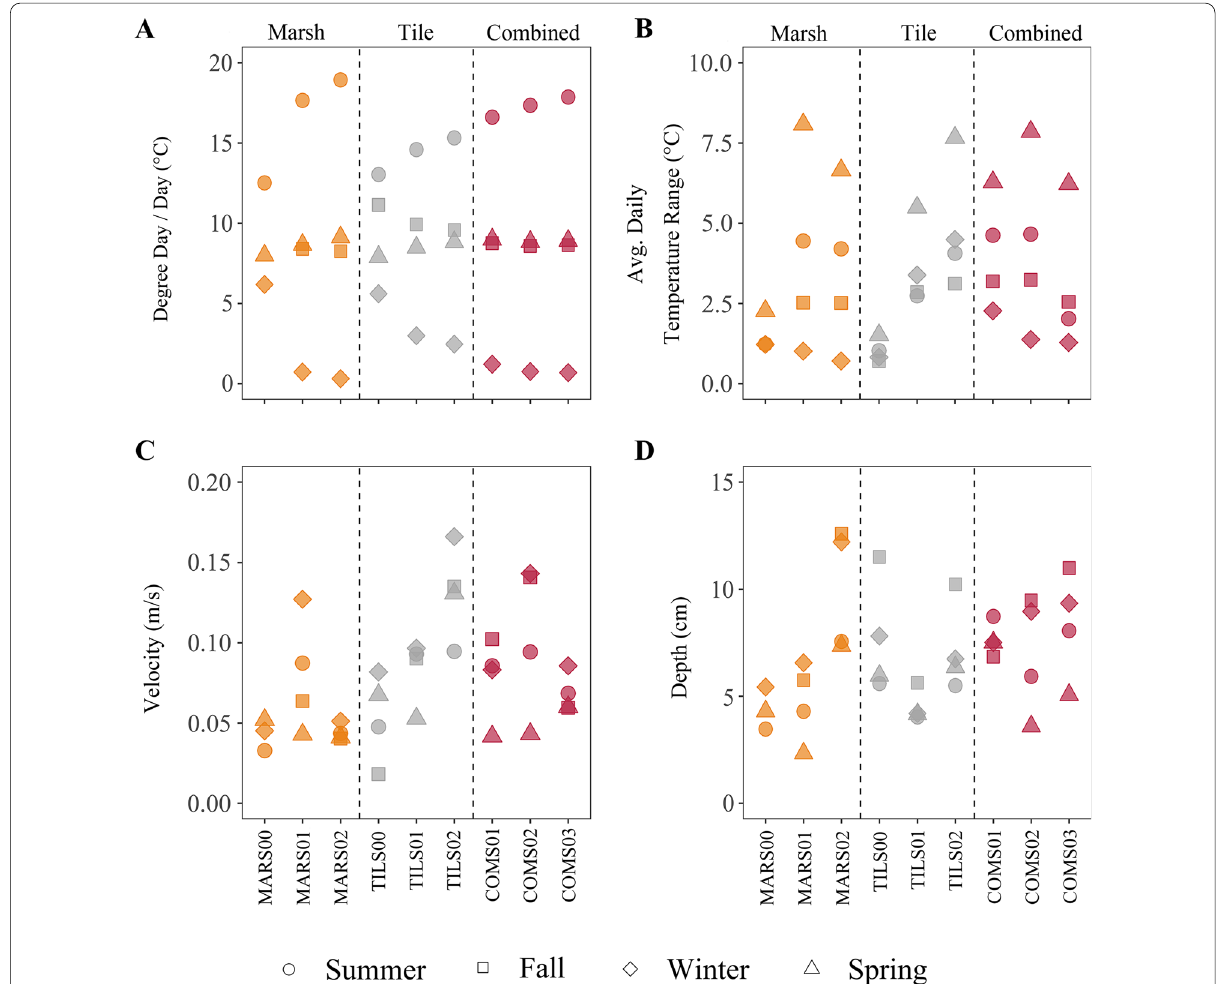
Fig. 7 Dot plots showing measured values of degree days/day ( A ) and average daily temperature range ( B ), as well as averaged instantaneous measures of stream velocity ( C ) and stream depth ( D ) above cotton strips deployed at the top, middle, and bottom positions of three segments (marsh (orange), tile (grey), and combined (magenta)) comprising a headwater stream branch in southwestern Ontario, Canada. Samples